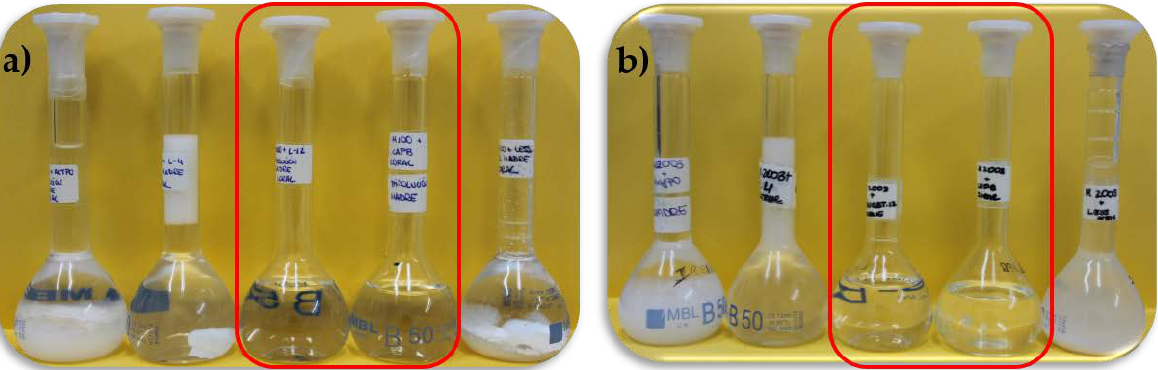
Figure 2. Set of images showing the aspect of the pseudo-binary polyelectrolyte–surfactant mixtures with the same composition of the components as in Table 2: ( a ) PDADMAC–surfactant mixtures; ( b ) Merquat 2003–surfactant mixtures. In both panels, the mixtures contain the following surfactants (from left to right): AKYPO, LE4, LE12, CAPB, and SLES. One-phase mixtures are surrounded by a red rectangle.